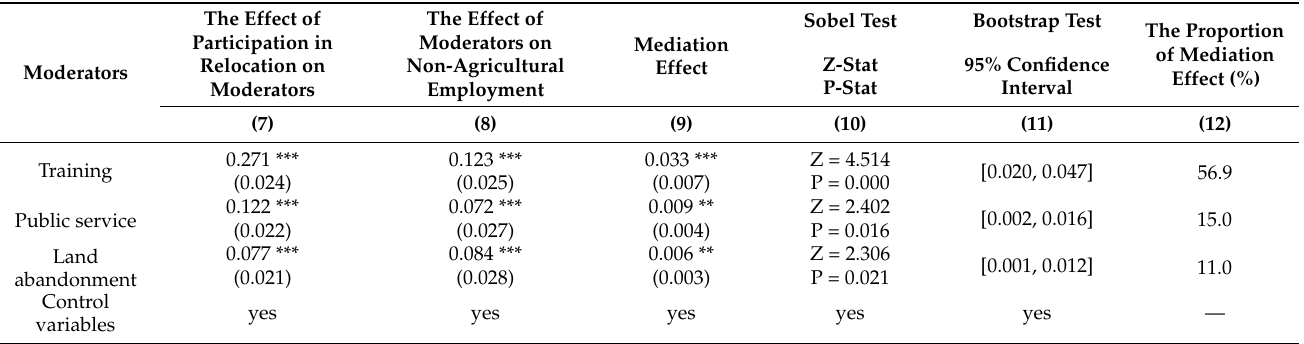
Table 4. Estimated results of the mediation effect in the effect of participation in relocation on non-agricultural employment